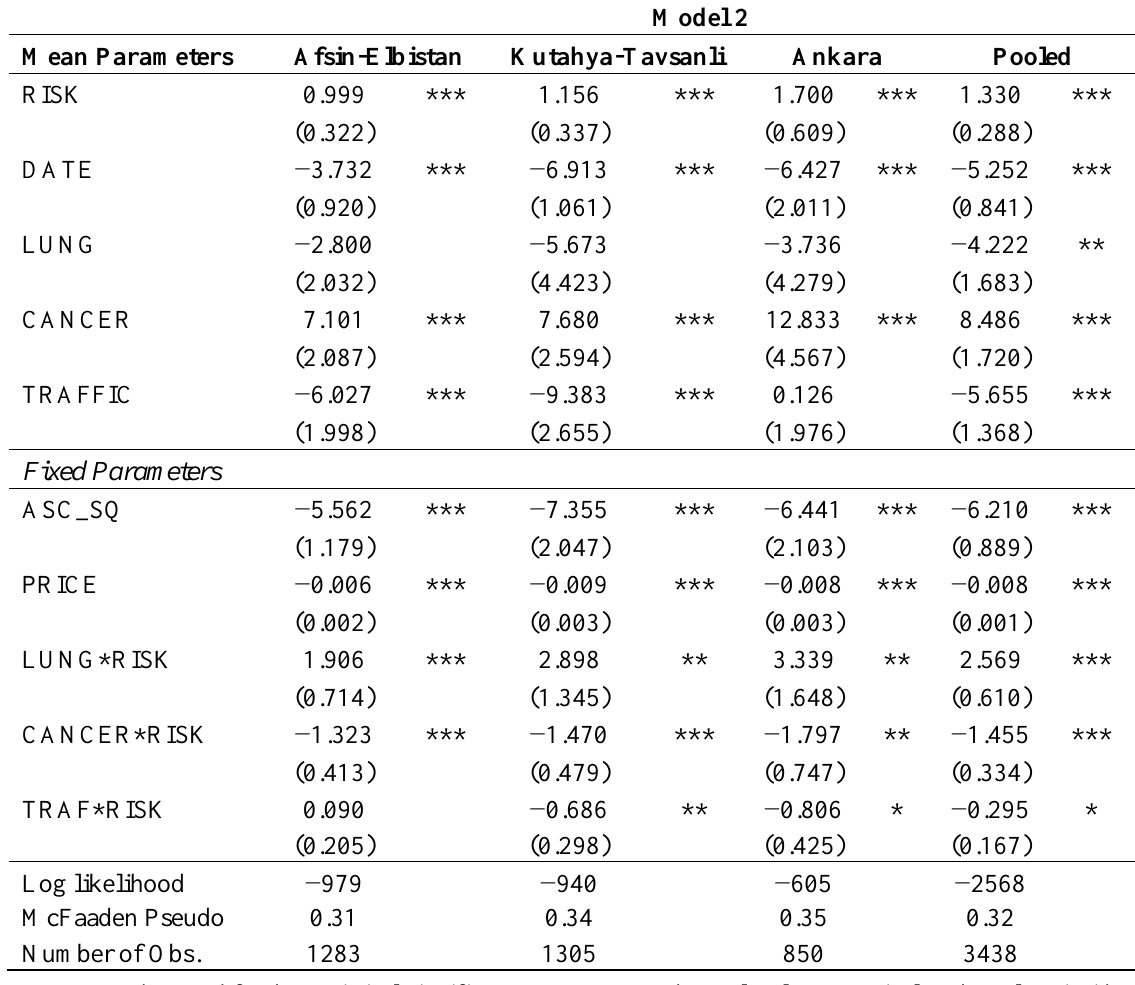
Table 7. Estimated Result and Risk Type Premium for Model 2.